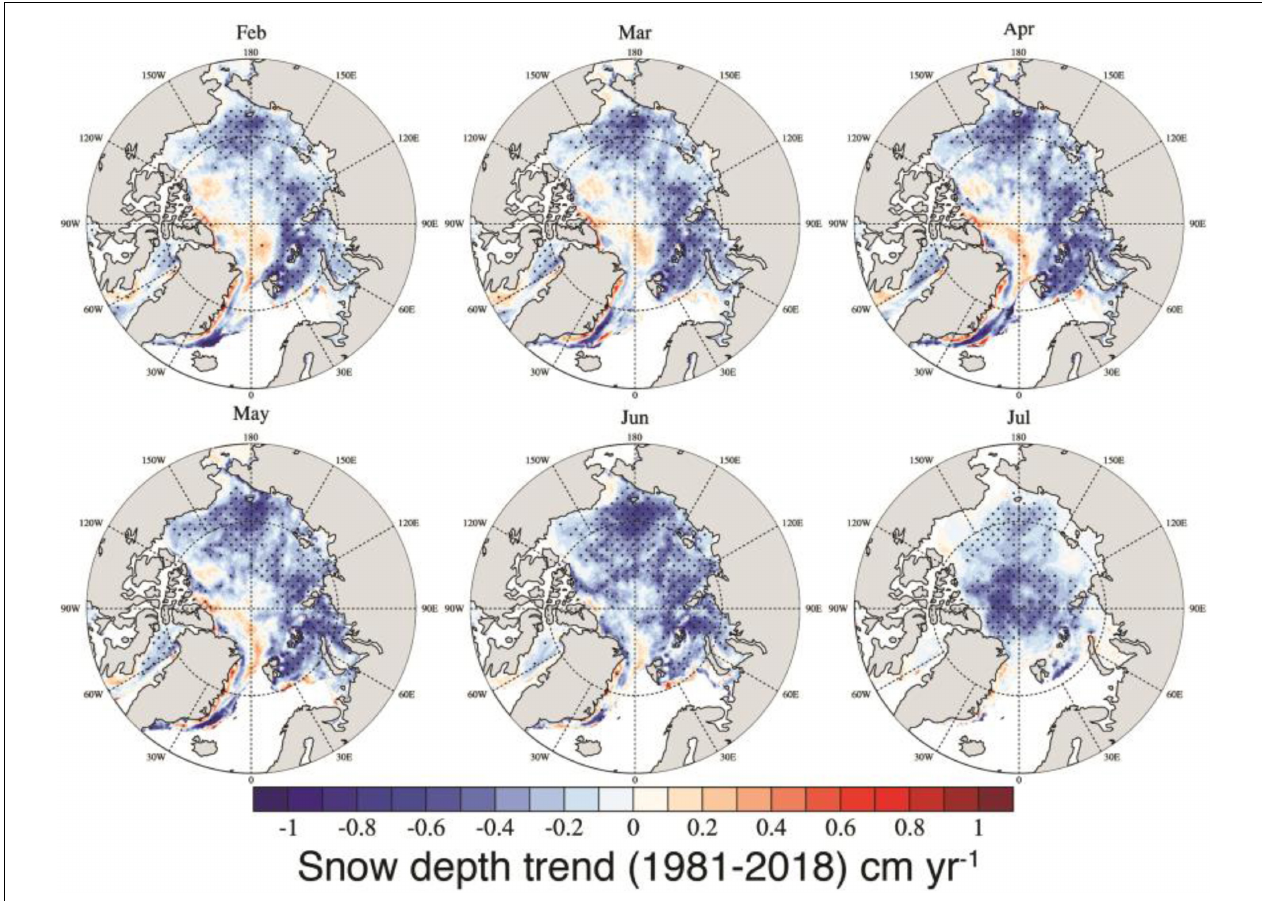
FIGURE 13 | Snow depth trends (cm/yr) in February through July from 1982 to 2018 over Arctic sea ice as represented in SnowModel-LG (Liston et al., 2020) forced by MERRA-2 atmospheric reanalysis. Trends statistically significant at the 95% confidence level are indicated by black